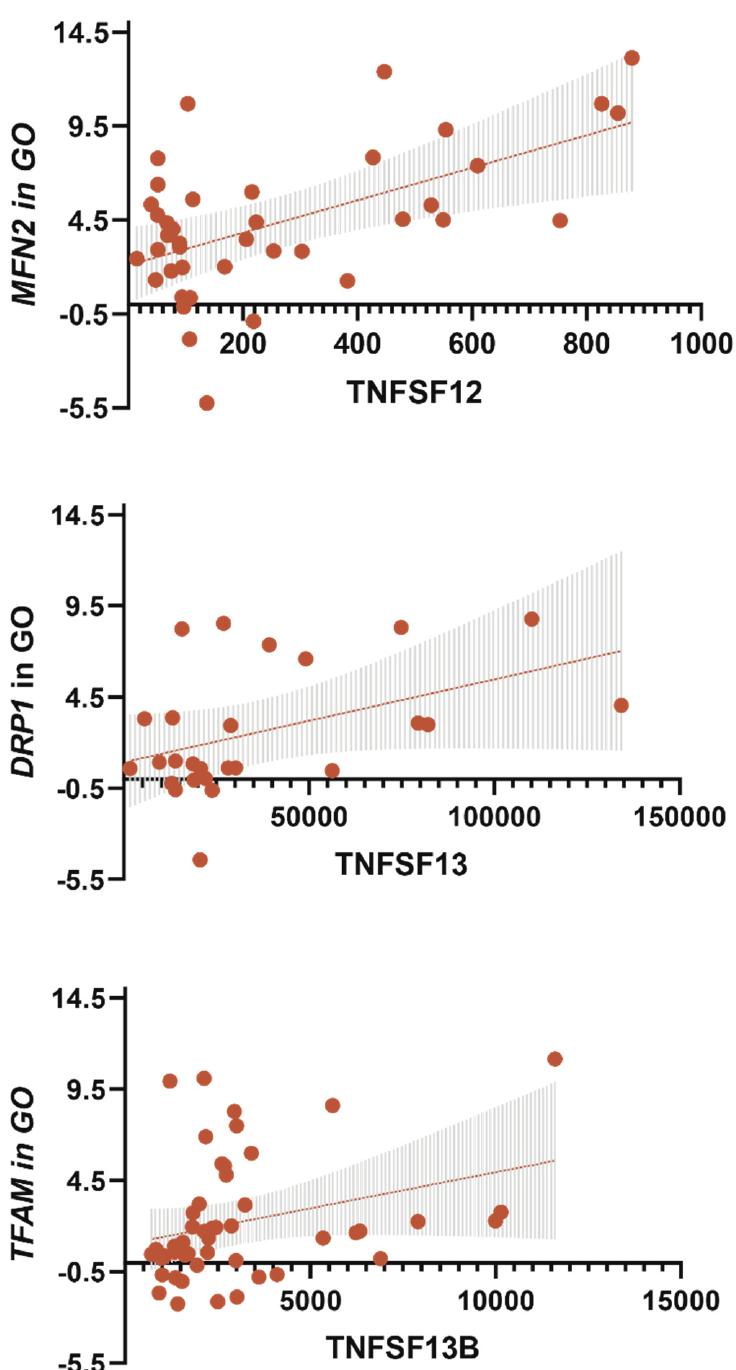
Figure 11. Linear regression analysis for TNF receptors and ligands with DNM1L, MFN2, and TFAM gene expression in GO.